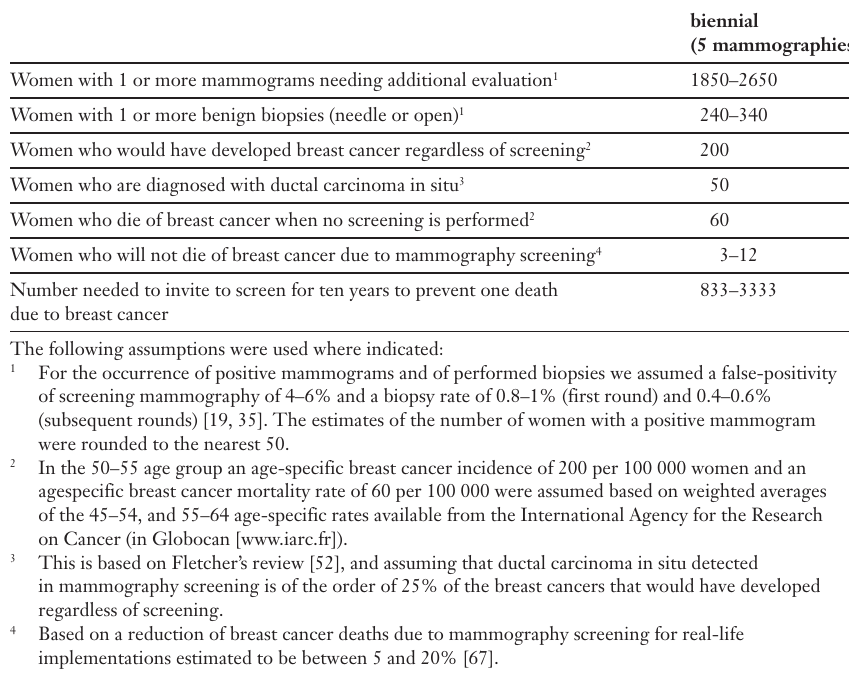
Sensitivity and speci- ficity of screening mammography for early detection of breast cancer in women aged 50–69 years estimated from randomised trials (based on three sys- tematic reviews [10, 16, 17]).